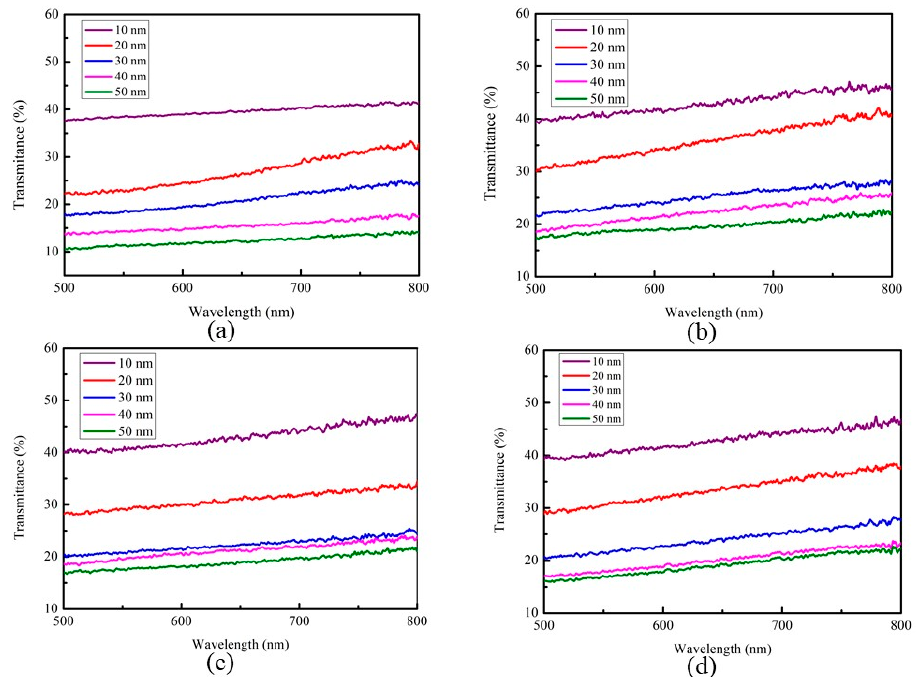
Figure 9. Transmittance of CoFeBY films. ( a ) RT, ( b ) after annealing at 100 °C, ( c ) after annealing at 200 °C, ( d ) after annealing at 300°C.